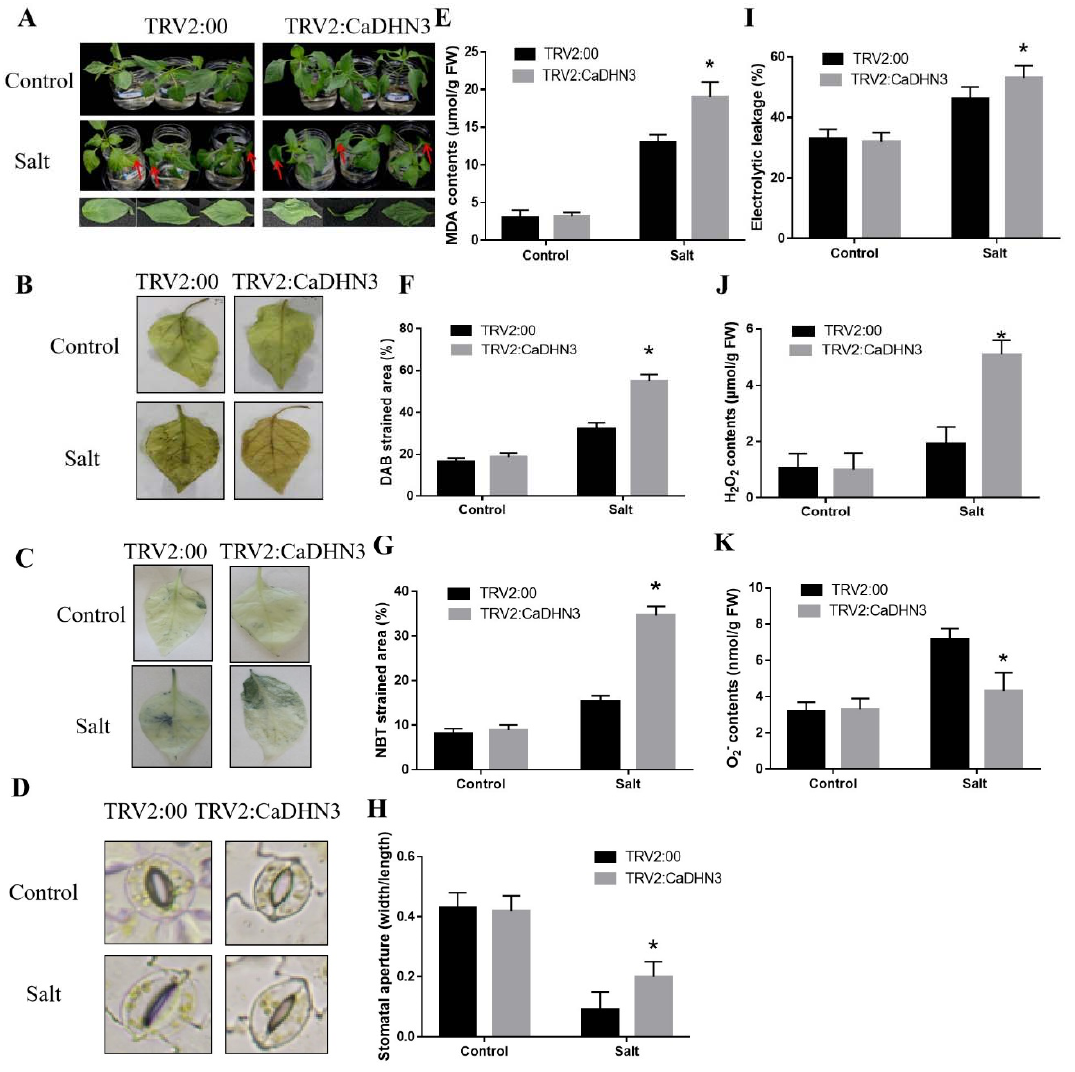
Figure 2. Physiological indies measurement under salt stress. ( A ) Phenotypes of silenced pepper plants under salt stress. ( B ) DAB staining. ( C ) NBT staining. ( D ) Stomatal conductance. ( E ) malondialdehyde (MDA) content. ( F ) % DAB strain areas. ( G ) % NBT strain areas. ( H ) Stomatal aperture. ( I ) Relative electrolyte leakage. ( J ) H 2 O 2 contents ( K ) O 2•− contents. Mean and S.D. values were obtained from three independent experiments. Asterisks indicate statistical significance (* p < 0.05, Student’s t -test) compared to control .